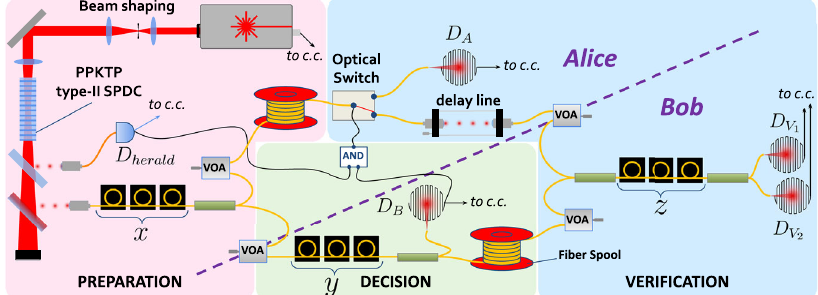
Fig. 2 | Experimental setup for cheat-sensitive quantum weak coin fl ipping. A ppKTPcrystal(30mm-long,46.2 μ mpolingperiod)ispumpedbya770nmpulsed laser ( ≈ 2 ps long pulses, 76 MHz rate). Twin photons at telecom wavelengths are generated via type-II SPDC, separated from the pump by a dichroic mirror (DM), andfromeachotherbyaPBS.Thesignalphotonisusedtoperformtheprotocolas shownintheschemeinBox1,whichisthereferenceforde fi ningthere fl ectivities x , y and z . These are tuned with polarization controllers, placed before PBSs. At the endofeachofthepossiblepaths,thesignalphotonisdetectedwithhigh-ef fi ciency , D V ).Acoincidencecounter(c.c.)conditionseachdetectionon SNSPDs( D A , D B , D V 1 2 theidlerphoton,detectedwithanInGaAsavalanchephotodiode(APD) D herald ,and